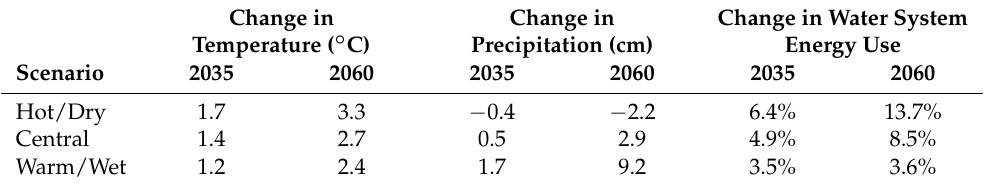
Table 1. Projected changes in temperature, precipitation, and water system energy use.